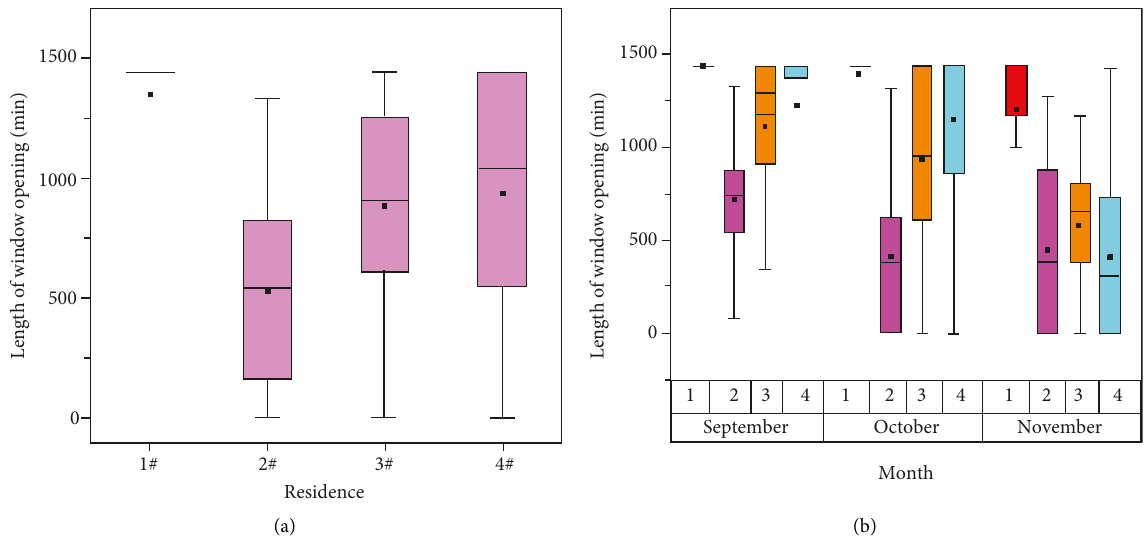
Figure 10: Box plot of the length of the window opening for each residence: (a) total length of window opening and (b) total length of window opening per month.